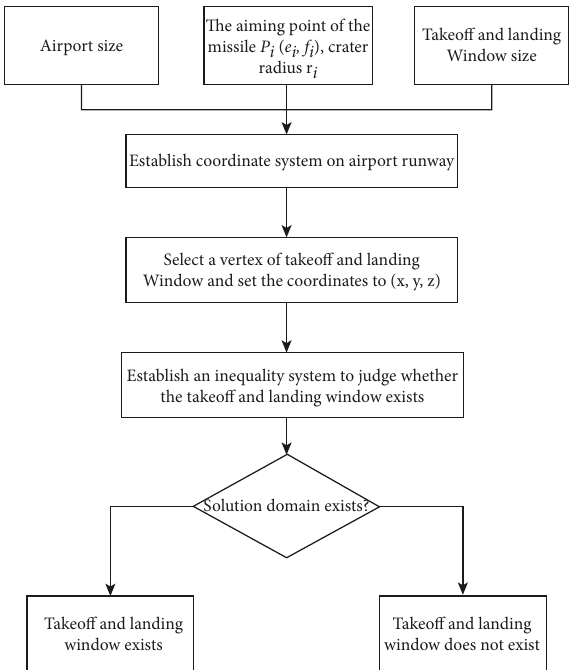
Figure 4: The flow of analyzing whether the takeoff and landing window exists.